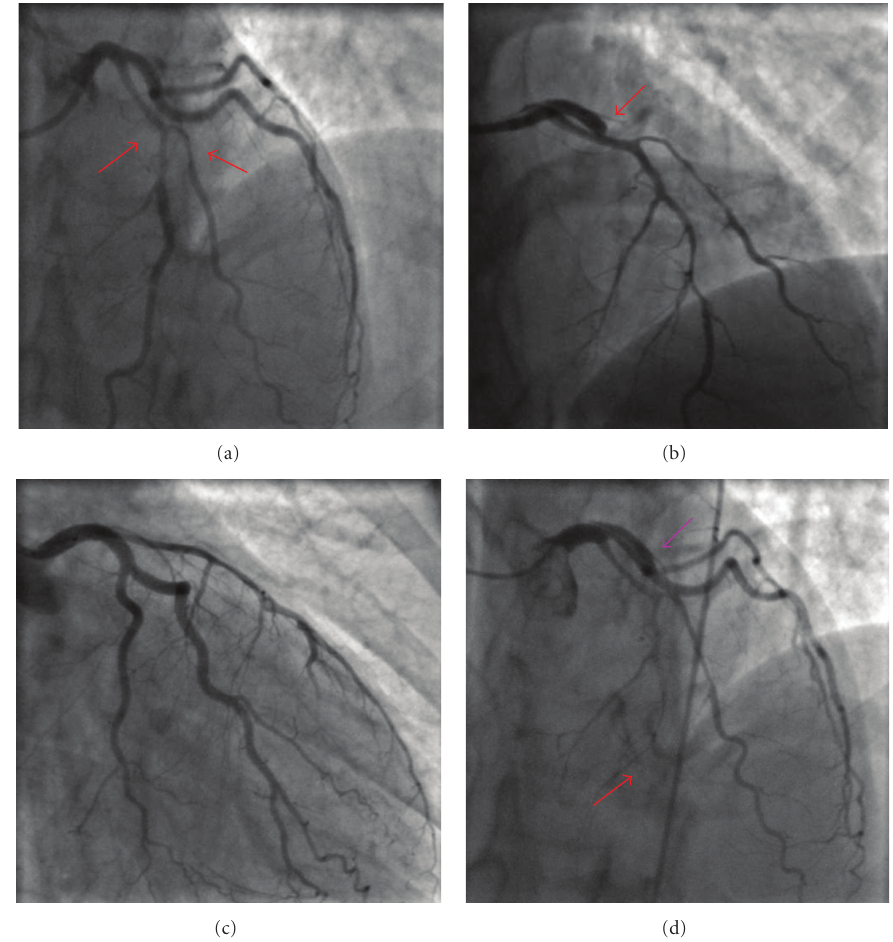
Figure 1: Angiographic projections (a) (35 ◦ LAO and 23 ◦ CRA): dissection of the left anterior descending (LAD) artery, involving the origin and proximal tract of the first diagonal branch (FDB) (red arrows); (b) (9 ◦ RAO and 39 ◦ CRA): progression of the dissection to the distal tract of the LAD and in the FDB, and proximal occlusion of the left circumflex artery (LCX) (red arrow); (c) (25 ◦ RAO and 23 ◦ CAU): angiographic result after POBA in the LCX; (d) (35 ◦ LAO and 23 ◦ CRA): distal occlusion of the LAD (red arrow) and patency of the LCX in spite of the presence of a persistent line of dissection (violet